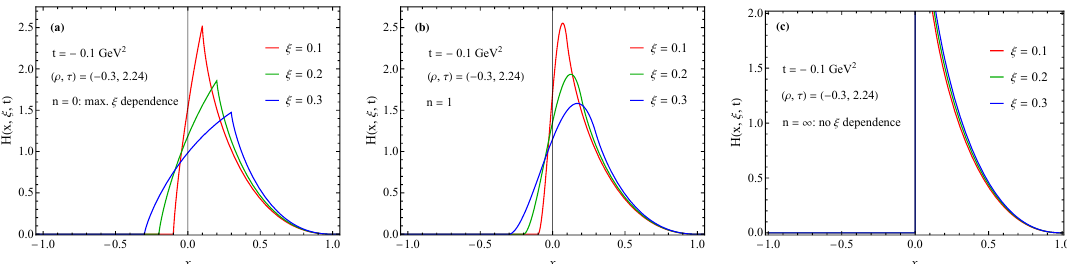
Figure 26. Chiral-even GPD H ( x, ξ, t ) as a distribution of x for three different ξ and three different values of n val , which controls the GPD ξ dependence in the GK model.